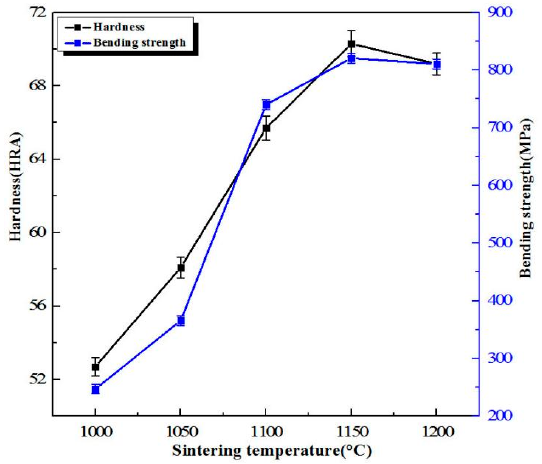
Figure 6. Hardness and bending strength of W-6Ni-4Mn alloys at different sintering temperatures.